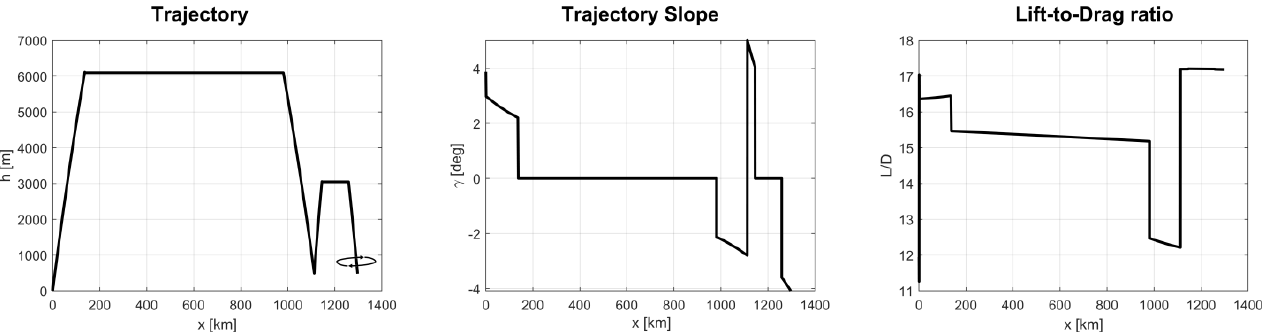
Figure 9. Mission simulation outcomes: trajectory (left), slope angle (centre), lift – drag ratio (right).